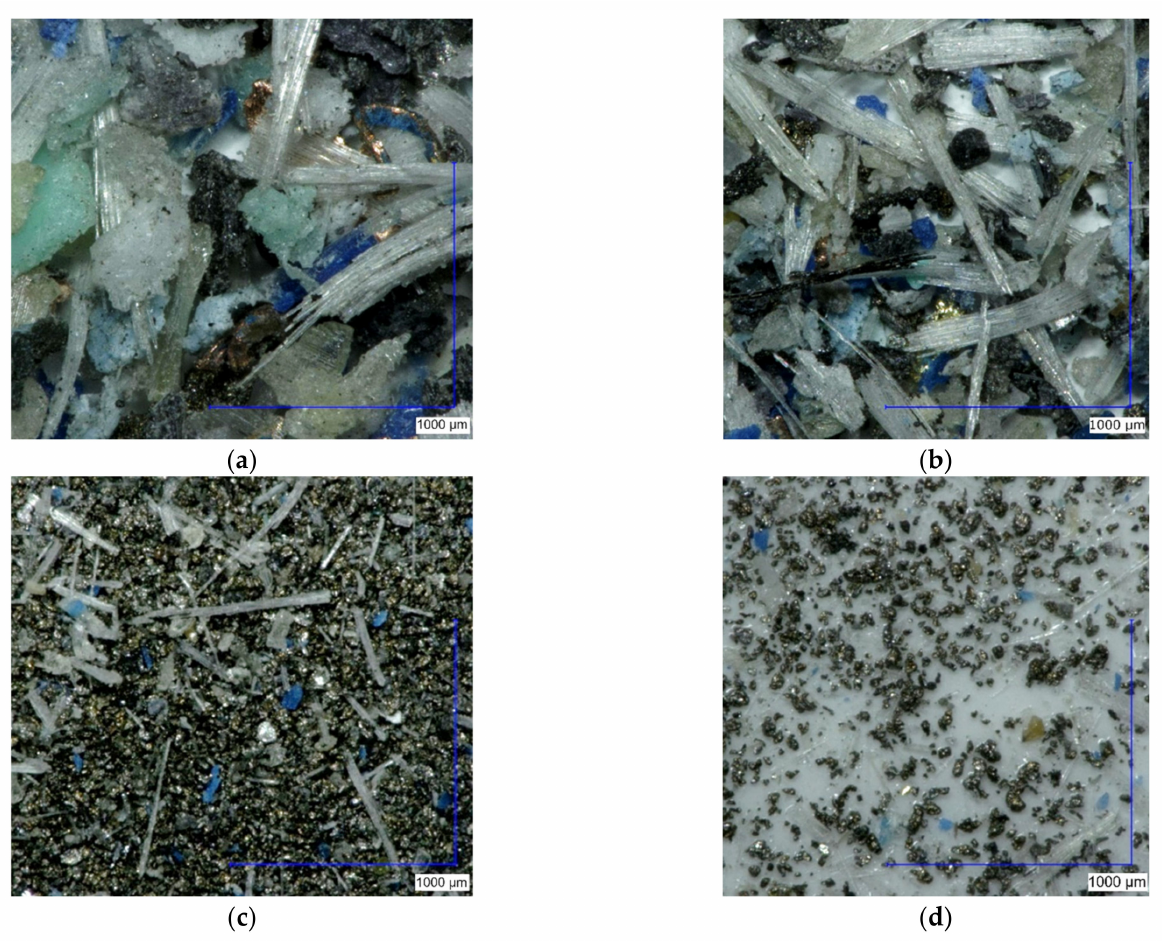
Figure 6. Optical images of the fractions 0.711–1.4 mm ( a ); 0.355–0.711 mm ( b ); 0.09–0.18 mm ( c ); and <0.09 mm ( d ) after double-step milling (X1 (>2.8) + X2) of fraction >2.8 mm collected from the one-step milling.